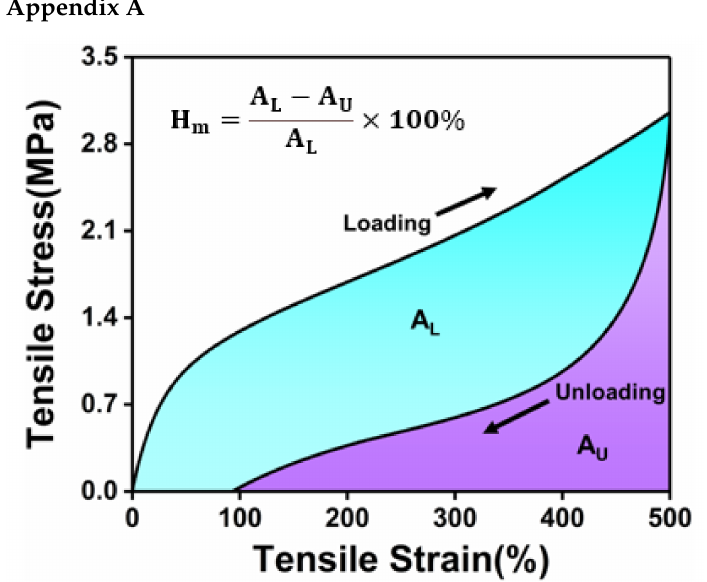
Figure A1. Schematic of the H m quantification using the areas in the stress–strain